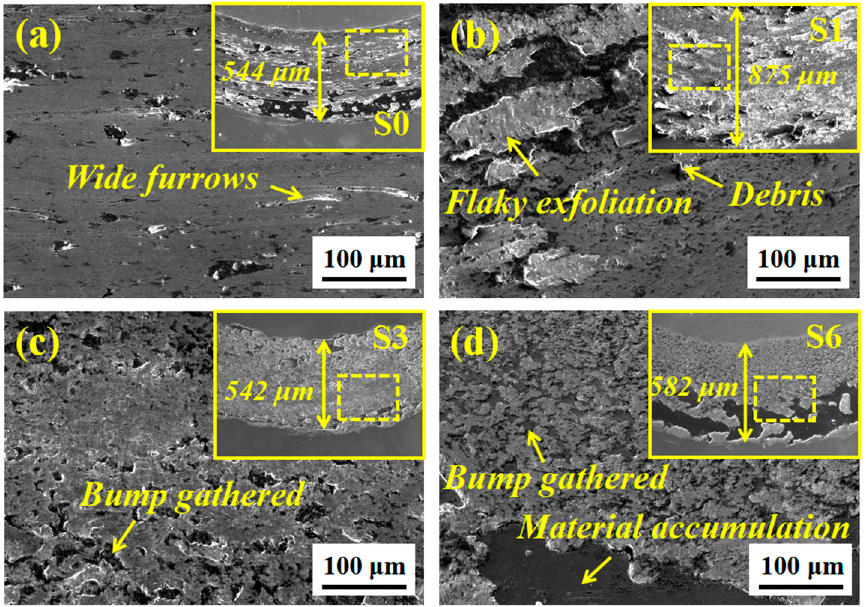
Figure 10. Typical SEM diagrams of the wear morphology of composite coating with different ceramic micro-particle. ( a ) S0; ( b ) S1; ( c ) S3; ( d )